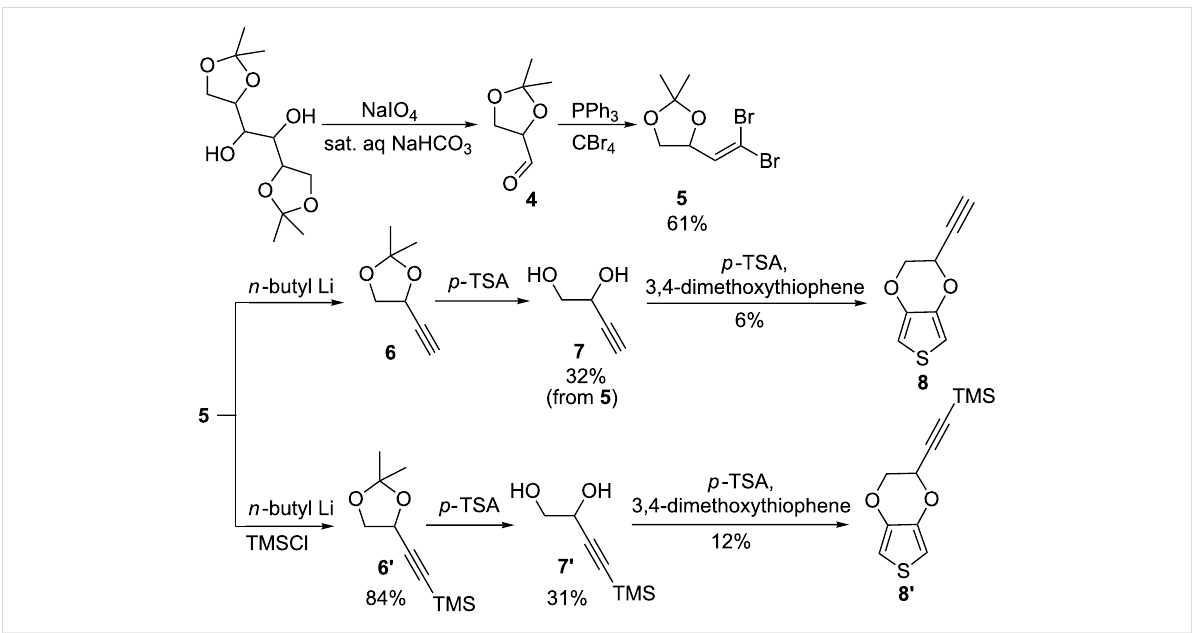
Scheme 3: The synthetic route from D-mannitol diketal to eEDOT 8 and TMS-eEDOT 8’ .